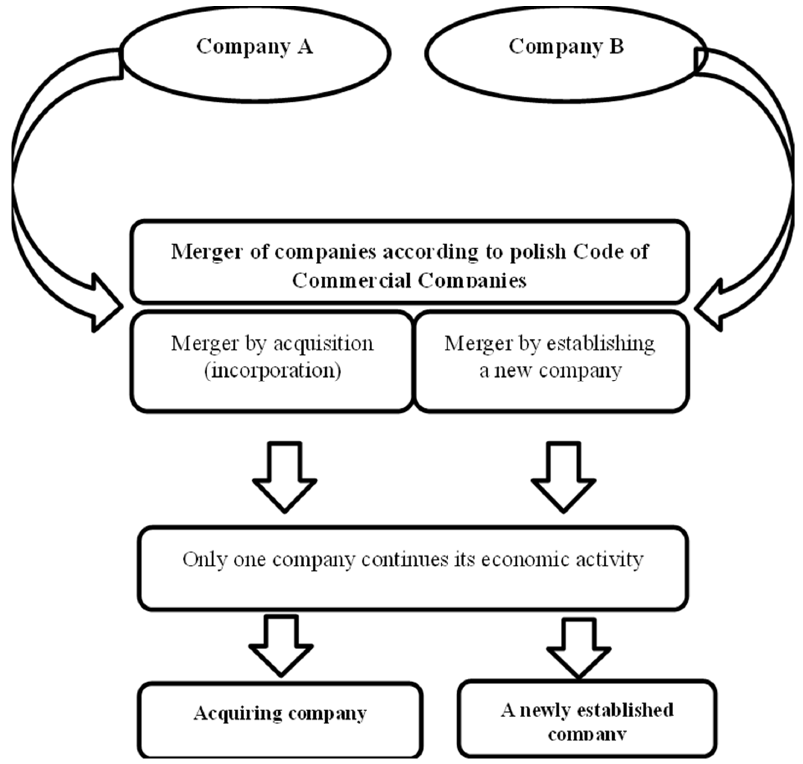
Figure 1. Sample characteristics by Source: author’s study based on art. 693 Polish Code of Commercial Companies.